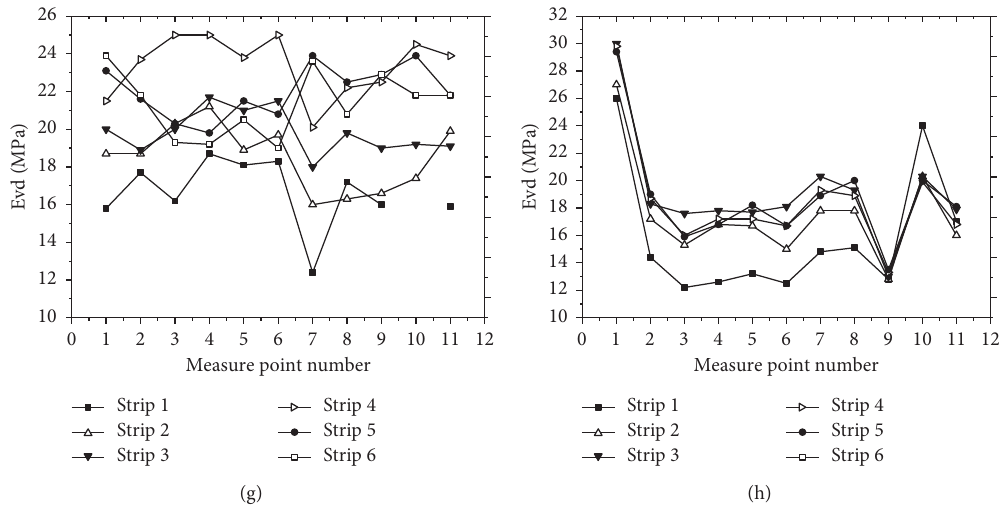
Figure 3: E vd test results. (a) WC 1; (b) WC 2; (c) WC3; (d) WC 4; (e) WC 5; (f) WC 6; (g) WC 7; (h) WC 8.